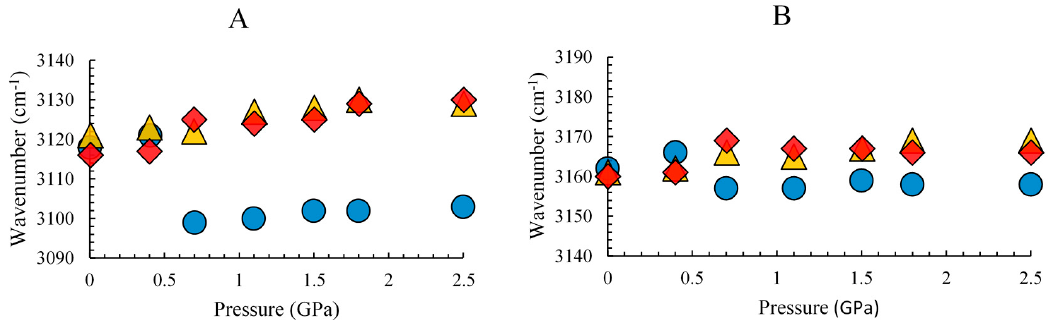
Figure 3. Pressure dependence of the imidazolium C–H stretching frequencies at ( A ) 3120 and ( B ) 3160 cm − 1 of pure 1,3-dimethylimidazolium methyl sulfate (circles), Al 2 O 3 /1,3-dimethylimidazolium methyl sulfate mixture (triangles), and mica/1,3-dimethylimidazolium methyl sulfate mixture (diamonds).